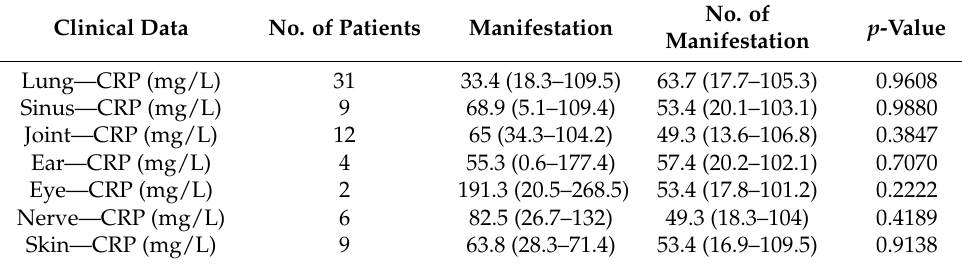
Table 1. CRP levels after group separation by extrarenal manifestations of